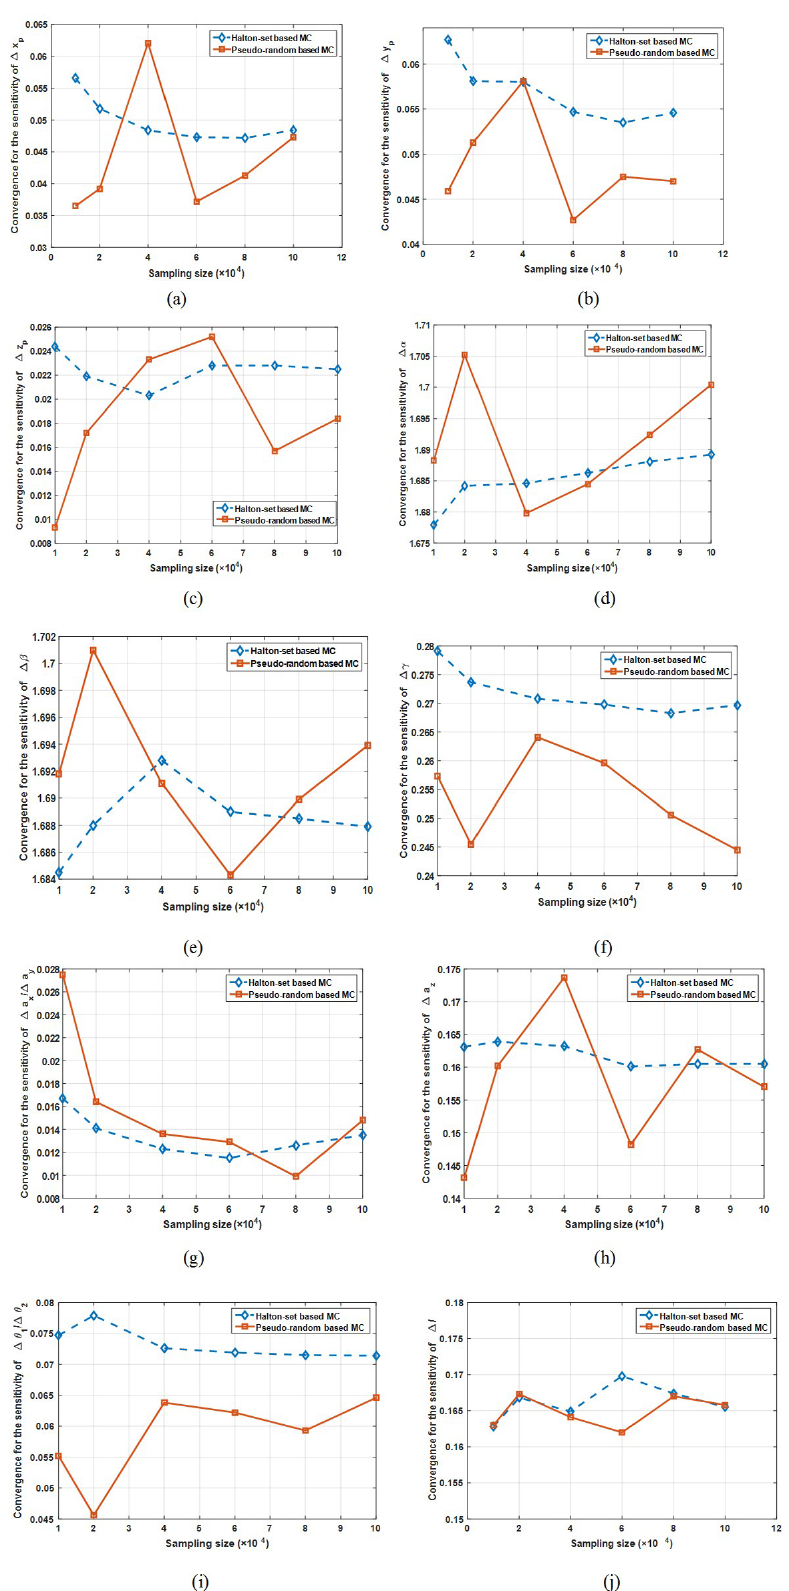
Figure 8. Convergence of the sensitivities for 10 tolerance